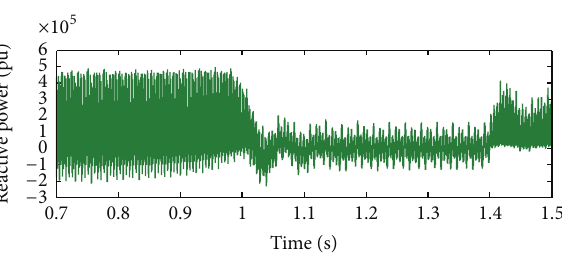
Figure 9: Load current during L-G